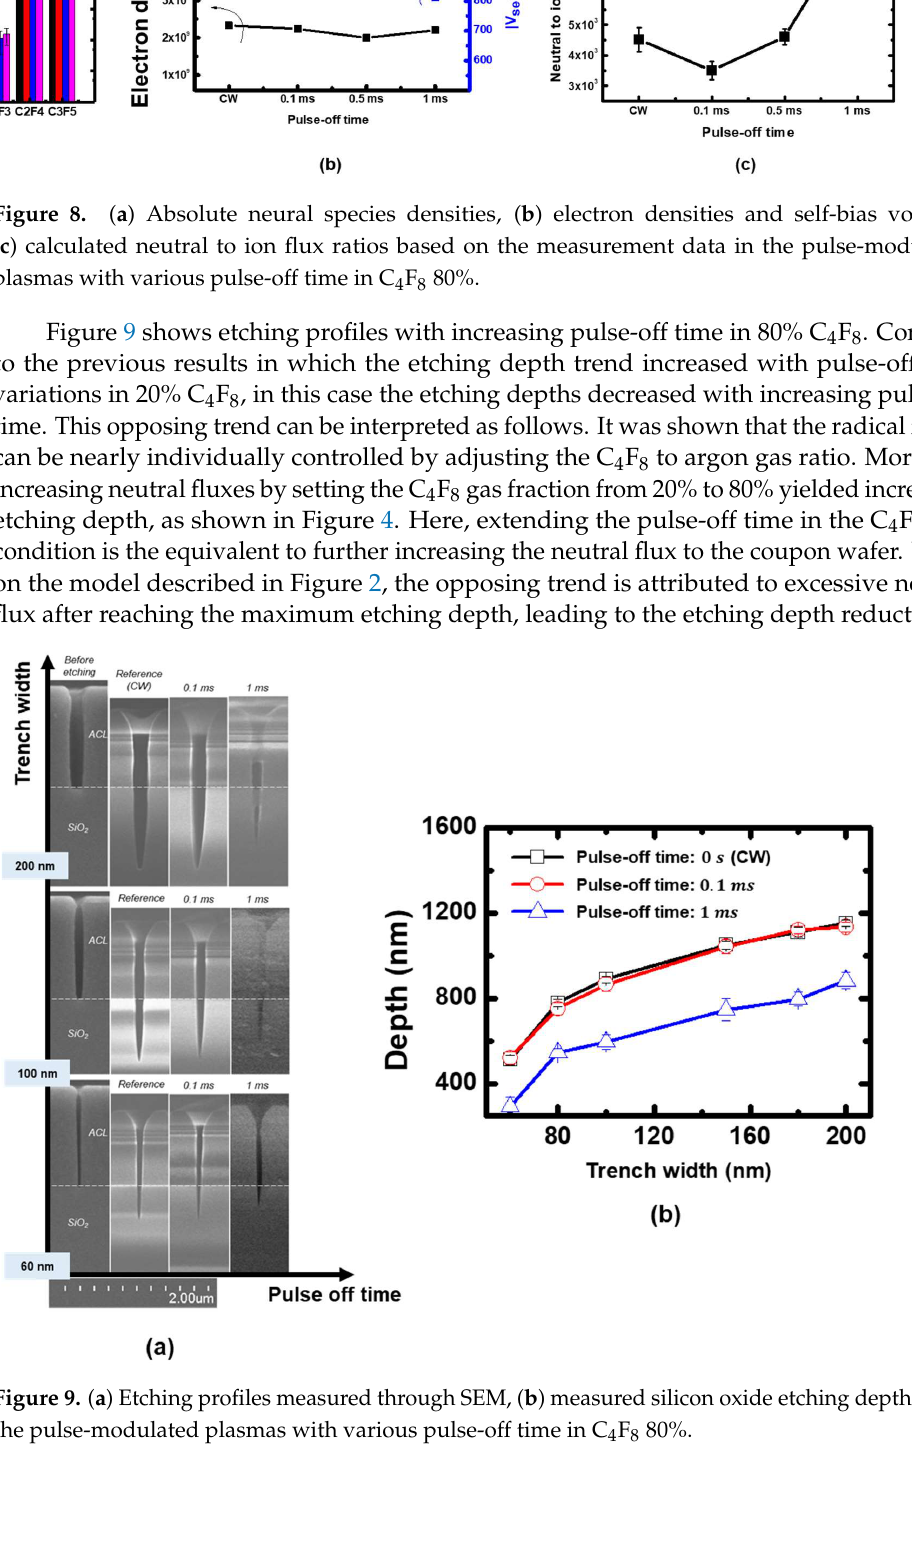
Figure 9. ( a ) Etching profiles measured through SEM, ( b ) measured silicon oxide etching depth un- der the pulse-modulated plasmas with various pulse-off time in C 4 F 8 80%. the pulse-modulated plasmas with various pulse-off time in C 4 F 8